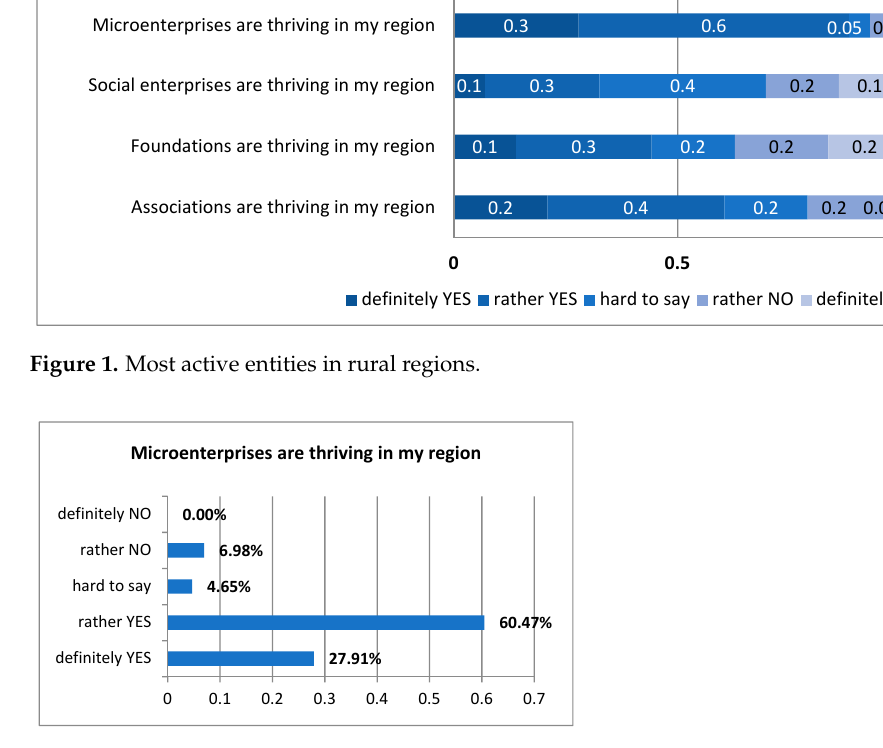
Figure 2. Opinion about activeness of microenterprises in the rural regions.